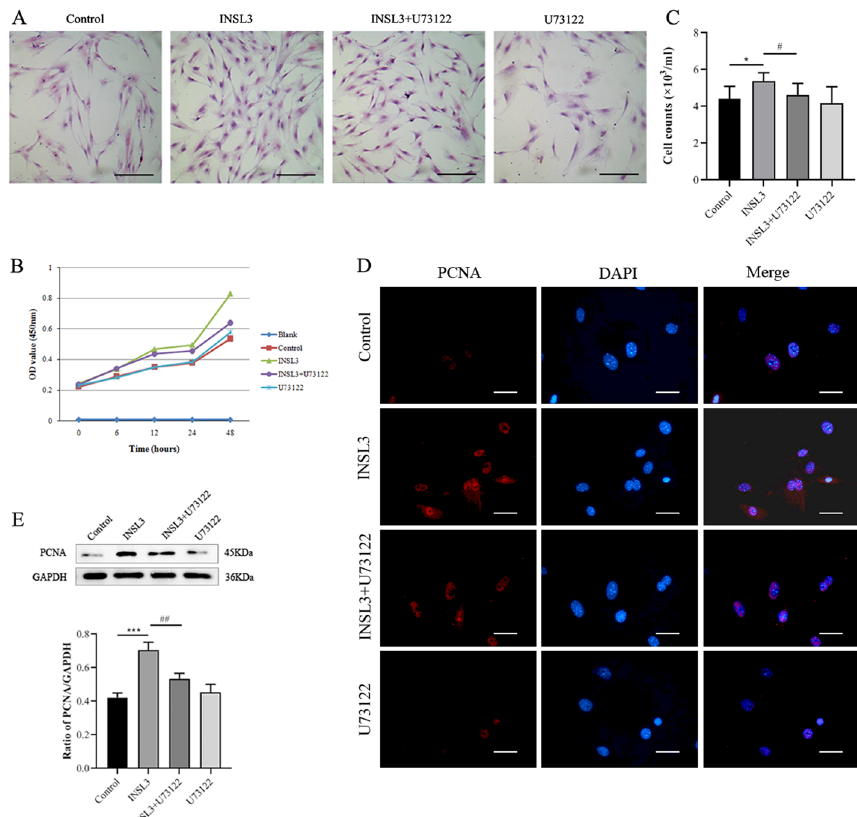
Fig. 1 U73122 inhibited the effect of INSL3 on the proliferation of gubernacular cells. A Cell morphology was observed by HE staining. Scale bars, 50 μm. B Cell proliferation was detected by CCK8. C Cell counting measures changes in the number of cells. The counting method is shown in Additional file 2: Fig. S2. D The expression of proliferating cell nuclear antigen (PCNA) was observed by immunofluorescence. Scale bars, 20 μm. E The expression of PCNA protein was analyzed by Western blot. Data are mean of three independent experiments. * &# P < 0.05, ** &## P < 0.01, and *** &### P <